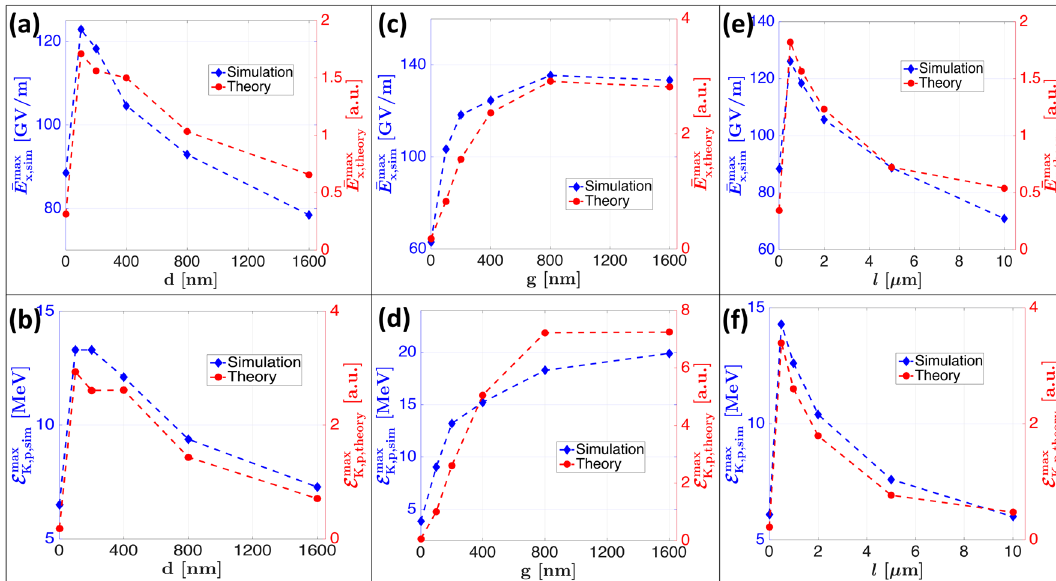
max x, sim (blue diamonds) calculated max x, theory (red dots).